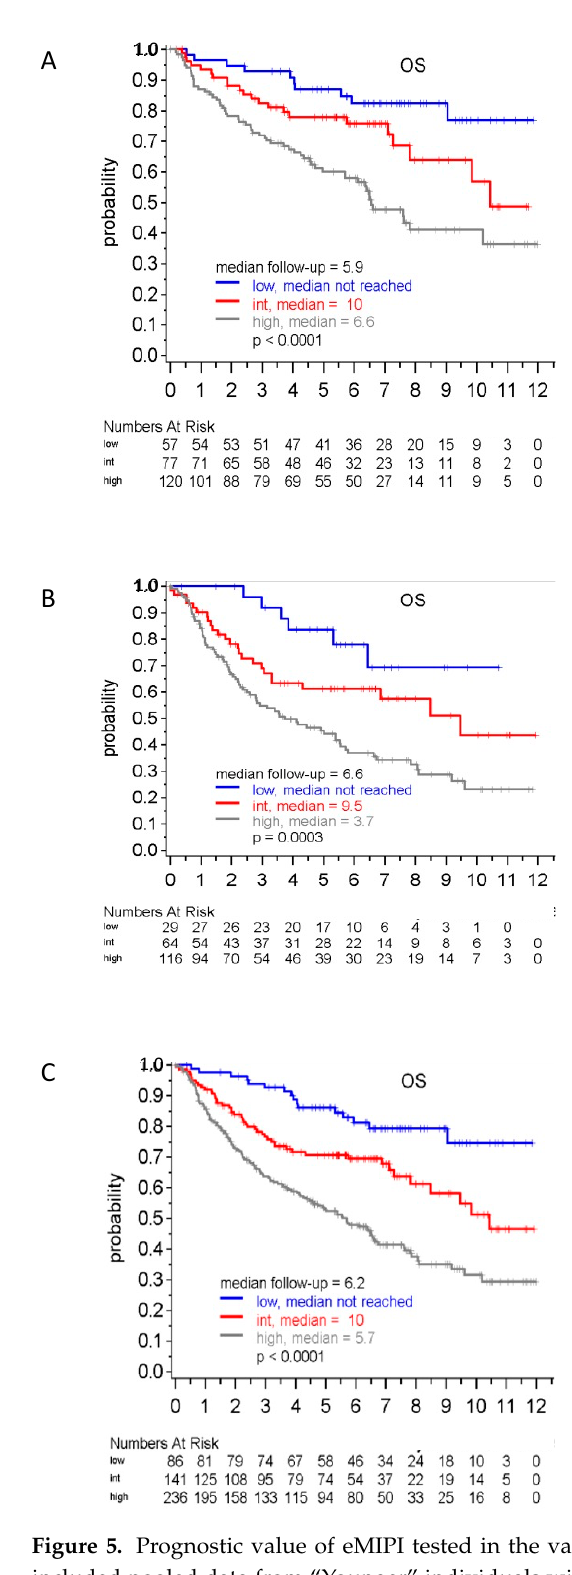
Figure 5. Prognostic value of eMIPI tested in the validation cohorts. ( A ) The validation cohort included pooled data from “Younger” individuals with MCL. ( B ) The validation cohort included pooled data from “Elderly” individuals with MCL. ( C ) The validation cohort included pooled data from “Younger” and “Elderly” individuals with MCL. Overall survival curves for the three risk groups and regression model analyses show distinctions between the different risk groups.